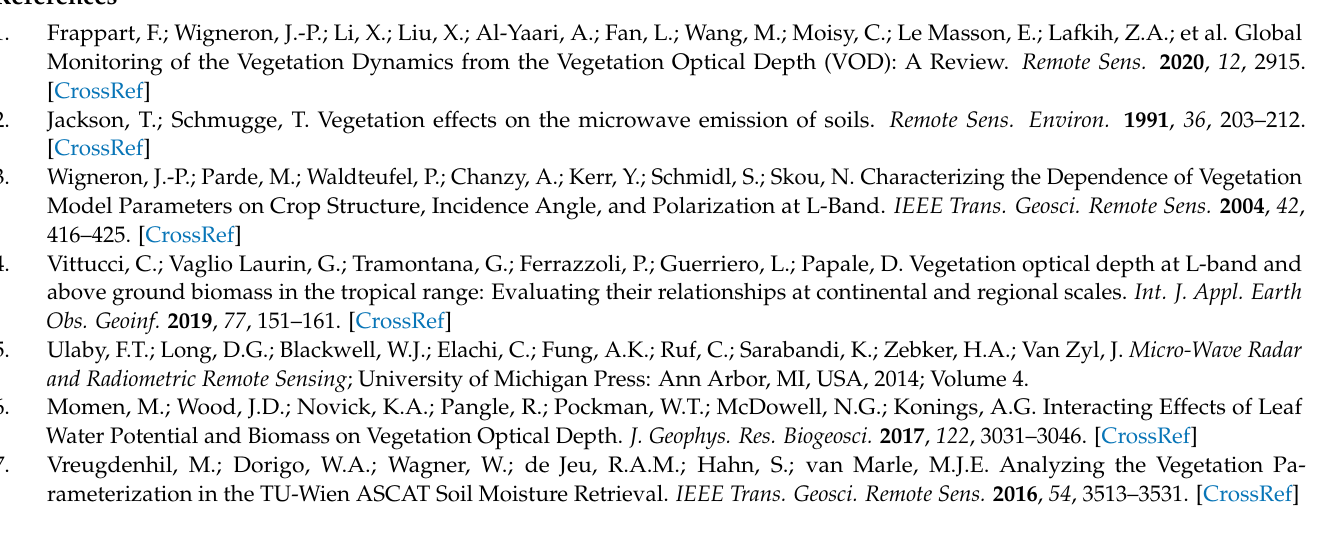
for D value. Figure S4. The computation results of the D values in 2020. (a) Map of the retrieved D soil parameter; (b) Map of the RF predicted D soil parameter; (c) histogram of the retrieved D and (d) scatterplot between the retrieved and RF predicted values for D value. Table S1. Surface parameters used to calibrate the soil model